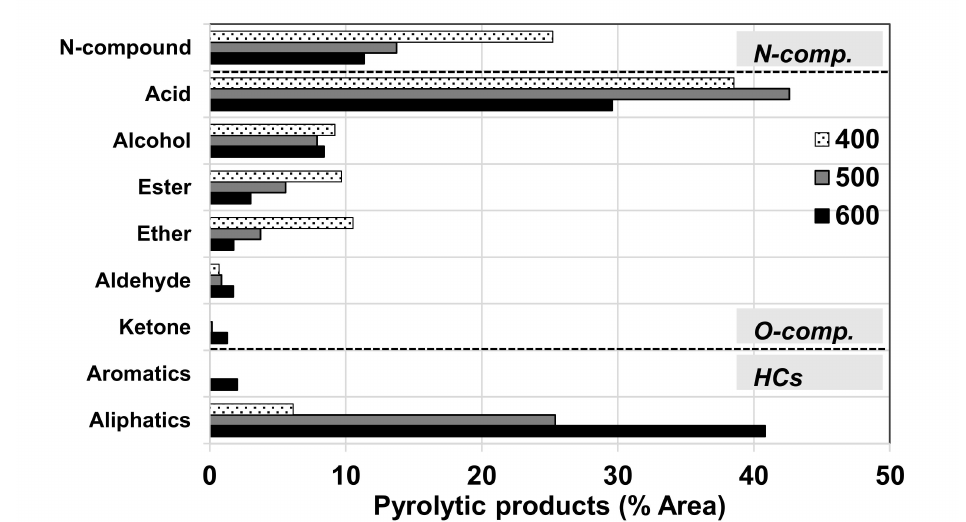
Figure 8. The non-catalytic product selectivity (% area) detected from GC / MS of SI residues pyrolyzed at 400–600 ◦